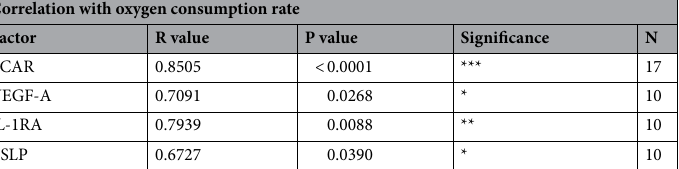
Table 1. Correlation of Metabolic rate with protein secretions in matched OAC treatment-naïve biopsies. The protein secretions of 54 mediators analysed by multiplex ELISA were correlated with real-time metabolic rate readouts of OCR of matched patient biopsies. ( A ) OCR was significantly correlated with the rate of ECAR and the secreted levels of 3 of 54 proteins including VEGF-A, IL-1RA and TSLP in matched OAC treatment-naïve biopsies. Secretions from explant tissue and metabolic rate were normalised to protein content. Spearman correlations; Spearman r 0.4–0.59 moderate, 0.6–0.79 strong, 0.8–1.0 very strong; * p < 0.05, ** p < 0.01, *** p <